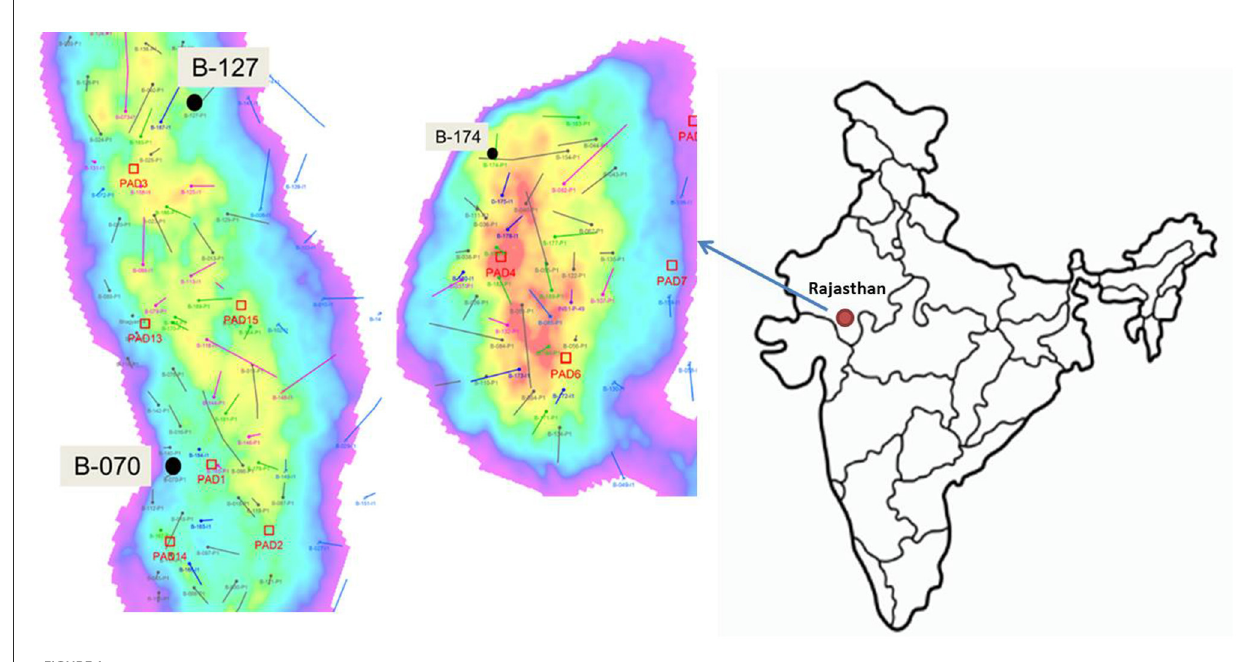
FIGURE1 Stratigraphy of Bhagyam oil fields and the neighboring area.